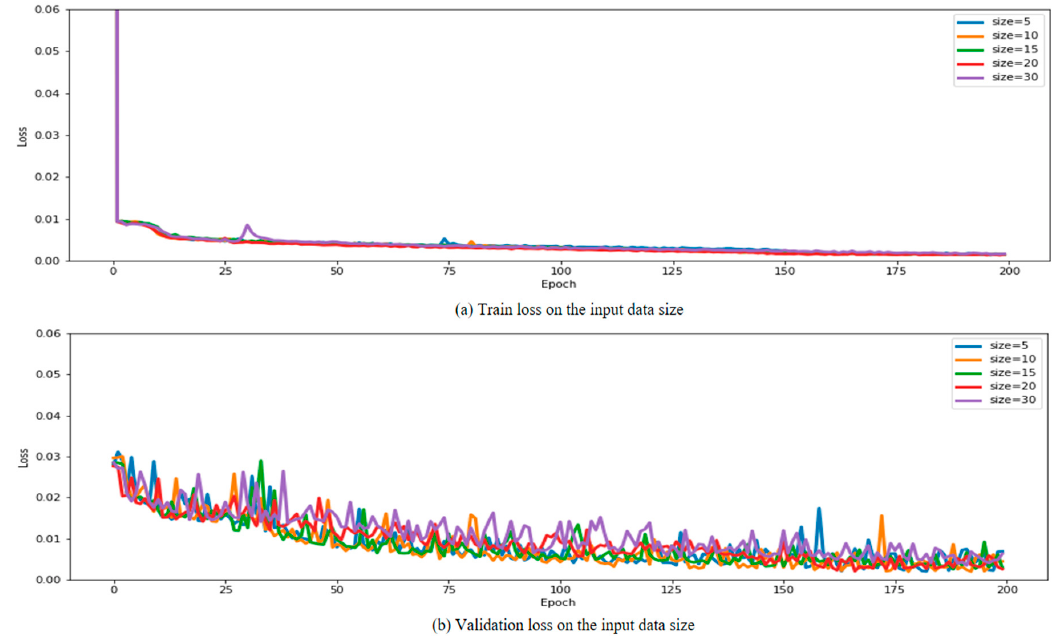
Figure 12. Train and validation loss values according to input data size. ( a ) Train loss on input data size; ( b ) validation loss on input data size.